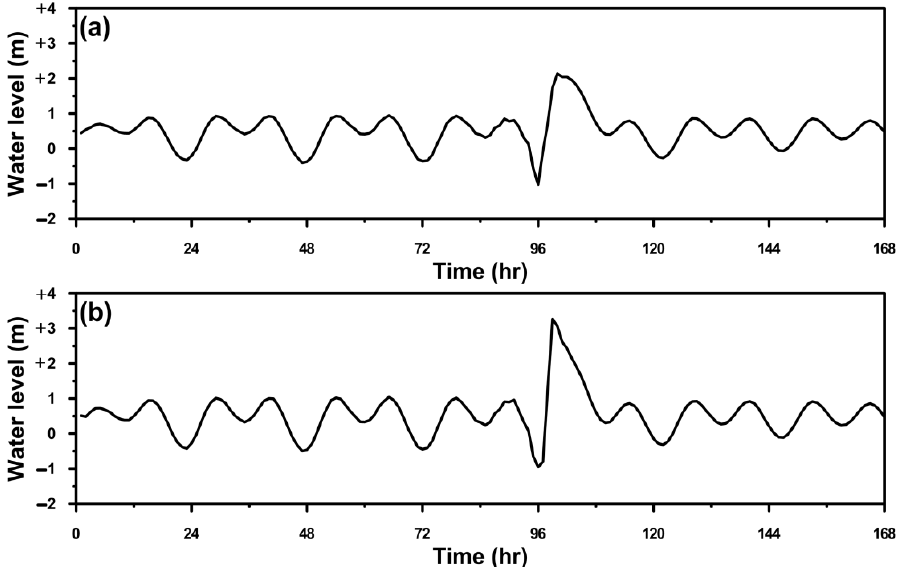
Figure 8. Time series for water level induced by a typhoon of similar intensity as Typhoon Haiyan in 2013 at ( a ) Jiangjun Fish Port and ( b ) Tsengwen River mouth.